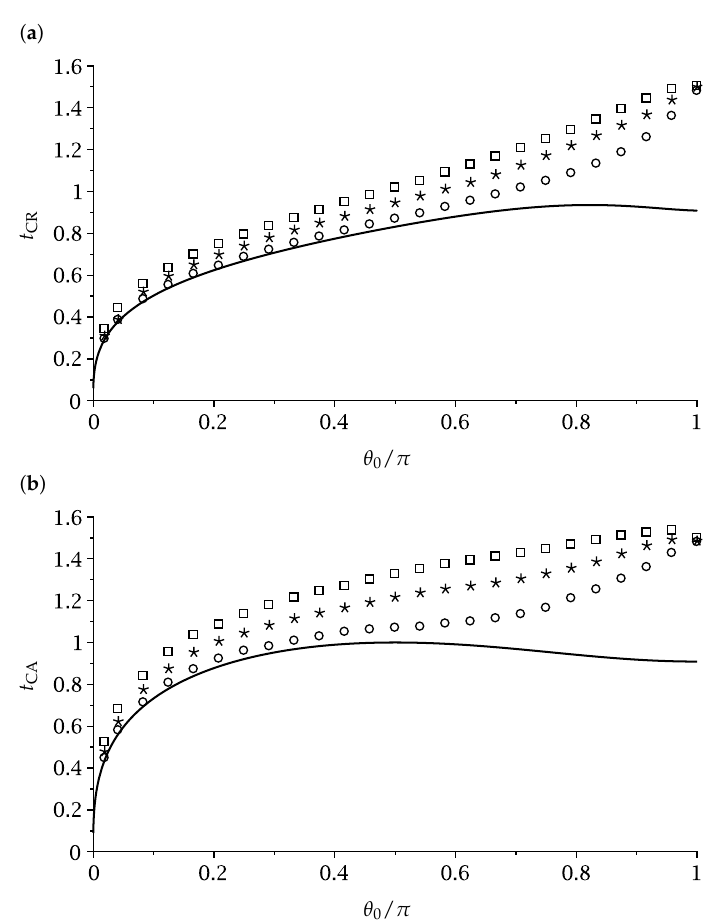
Figure 6. Numerically calculated dimensionless lifetimes of droplets of water with initial contact radius R = 1 mm in ( a ) the CR mode, t CR , and ( b ) the CA mode, t CA , evaporating into air with T ∞ = 295 K on aluminium ( k s = 237 Wm − 1 K − 1 , circles ), HDPE ( k s = 0.50 Wm − 1 K − 1 , stars (cid:63) ) and PTFE ( k s = 0.25 Wm − 1 K − 1 , squares (cid:3) ) substrates of thickness ◦ h s = 1 mm plotted as functions of the scaled initial contact angle θ 0 / π . The lifetimes have been nondimensionalised using the timescale (7), and the corresponding lifetimes according to the decoupled model obtained by Stauber et al. [9] are shown with solid lines.